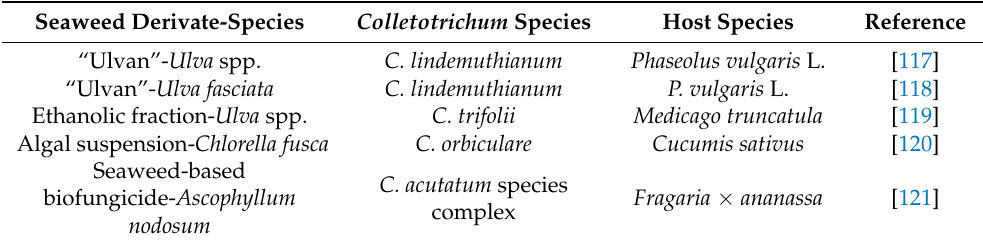
Table 3. Representative seaweed derivates for Colletotrichum spp. management. Seaweed Derivate-Species Colletotrichum Species Host Species